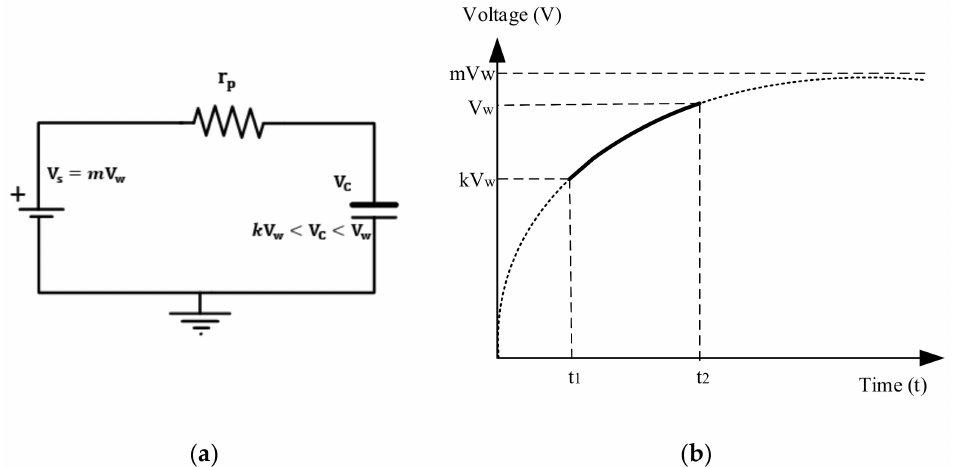
Figure 3. Modified Figure 2a by inserting a pre-charged supercapacitor: ( a ) longer time constant R-C circuit achieved by inserting a supercapacitor; ( b ) charging curve of the supercapacitor from pre-charge voltage (kV W ) to working voltage (V W ) which is below power supply voltage mV W